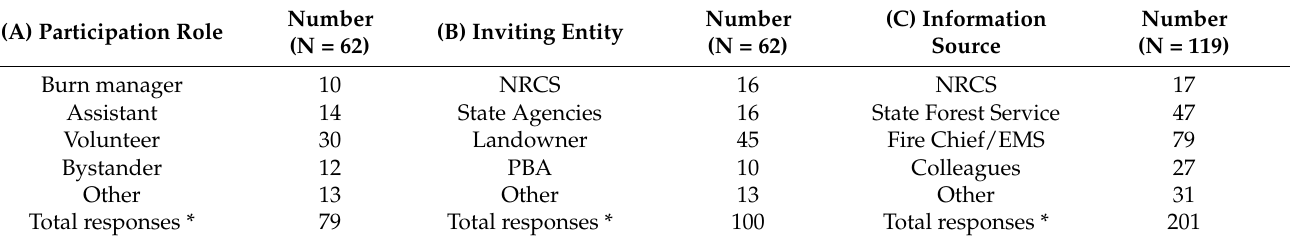
Table 1. (A) The role in which respondents reported being invited to participate/participated in a prescribed fire; (B) the entities that invited respondents to participate in a prescribed fire; (C) the sources that respondents used to obtain information about prescribed